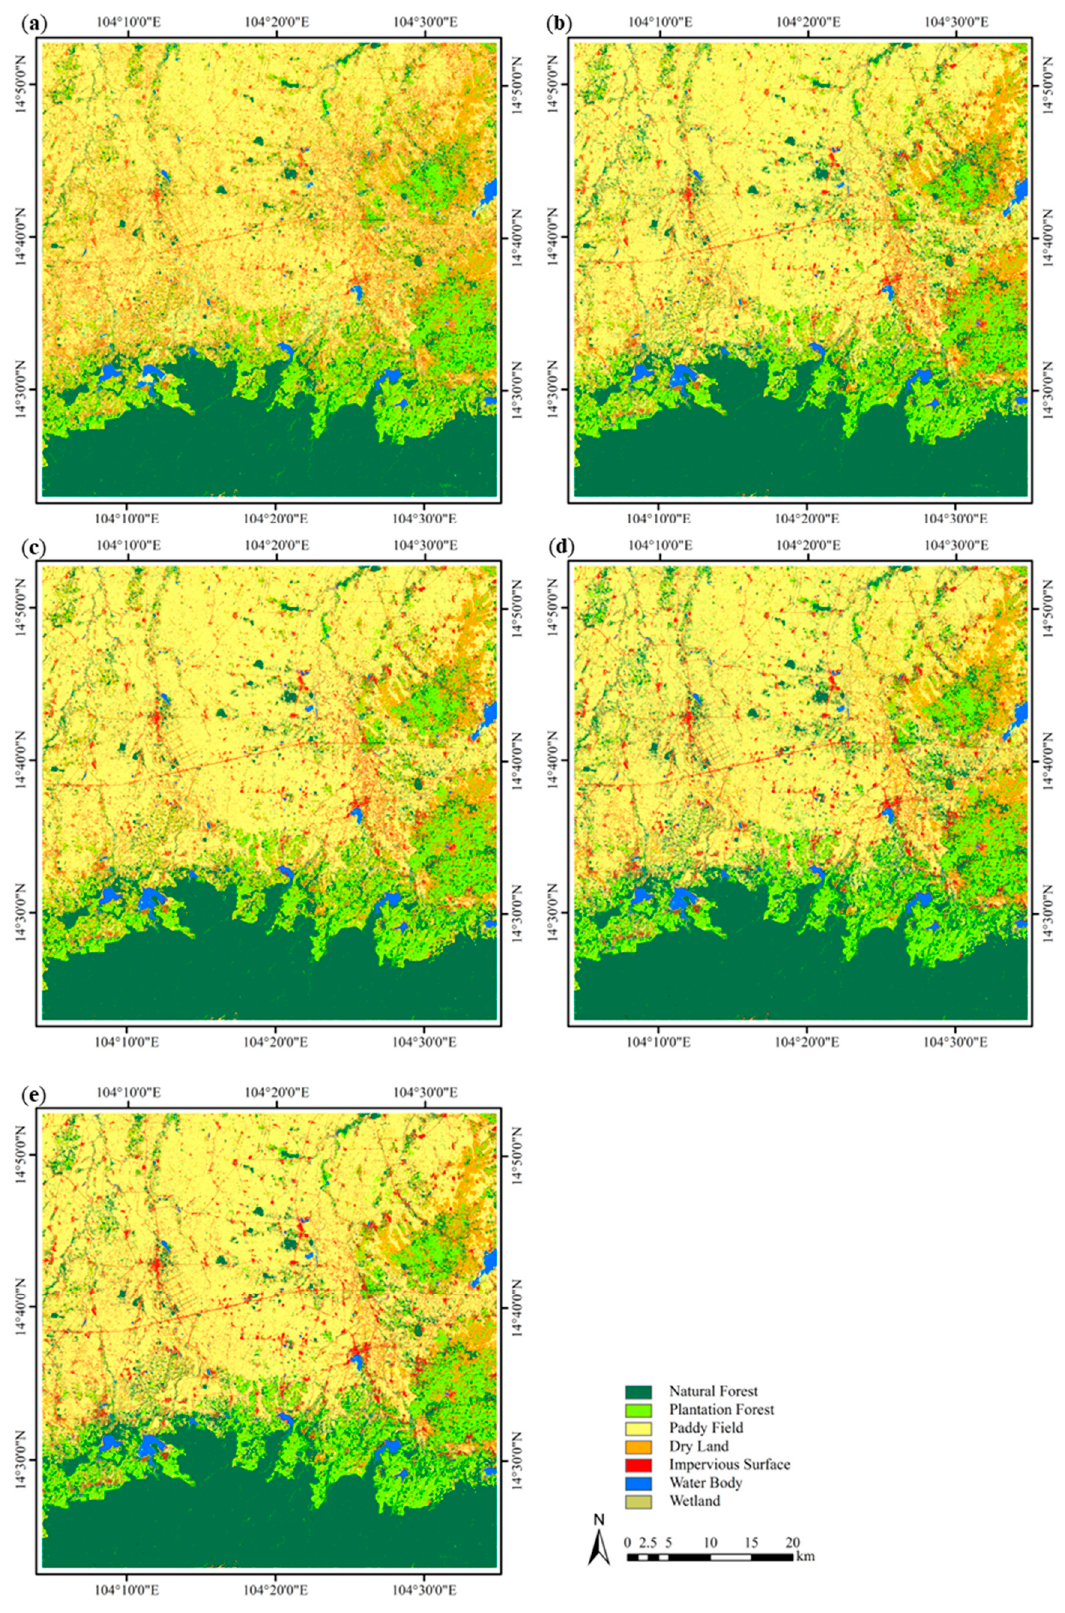
Figure 4. Classification results for ( a ) SB, ( b ) SBT, ( c ) SBTM, ( d ) SBTC, and ( e ) SBTMC combinations.